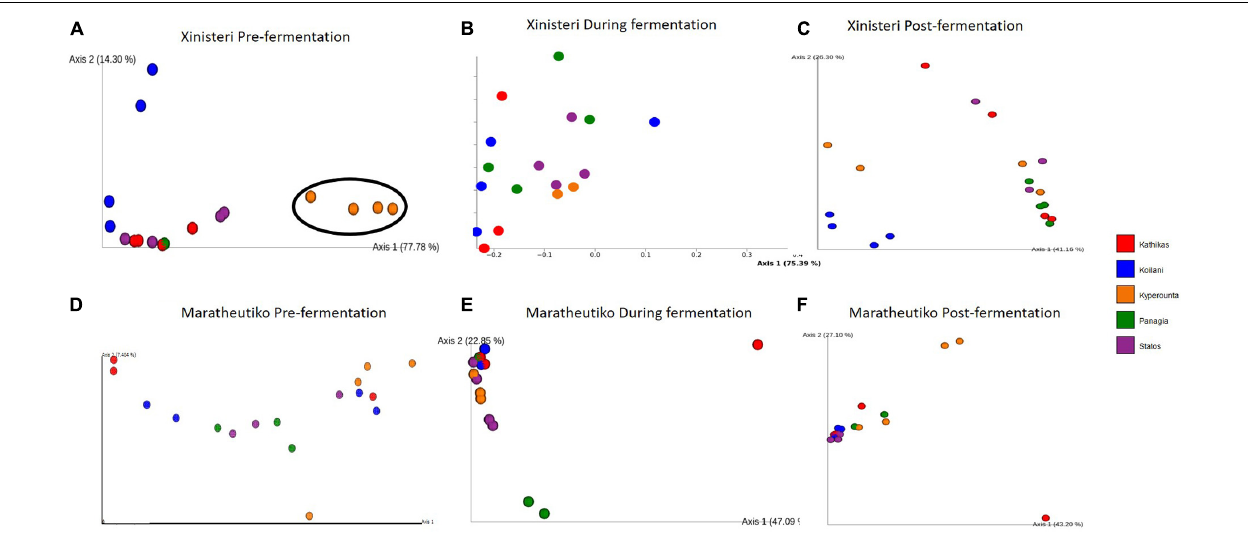
FIGURE 5 | Principal coordinate analysis plot, showing the similarities in the bacterial beta diversity according to the Bray-Curtis distance among the individual terroir : (A) for the variety Xynisteri pre-fermentation; (B) for the variety Xynisteri during fermentation; (C) for the variety Xynisteri post-fermentation; (D) for the variety Maratheftiko pre-fermentation; (E) for the variety Maratheftiko during fermentation; (F) for the variety Maratheftiko post-fermentation. Red circles represent Kathikas, blue circles represent Koilani, yellow circles represent Kyperounta, green circles represent Panayia and purple circles represent Statos. Ellipses show the separated terroir